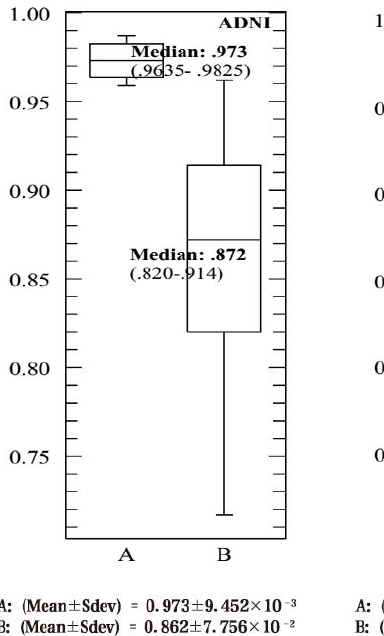
Figure 18. The corresponding Box-and-whisker plots of the descriptive statistics of the area under ROC curve (AUC) values for ADNI, OASIS and GMPH datasets with 20% additive noise, using 10 fold